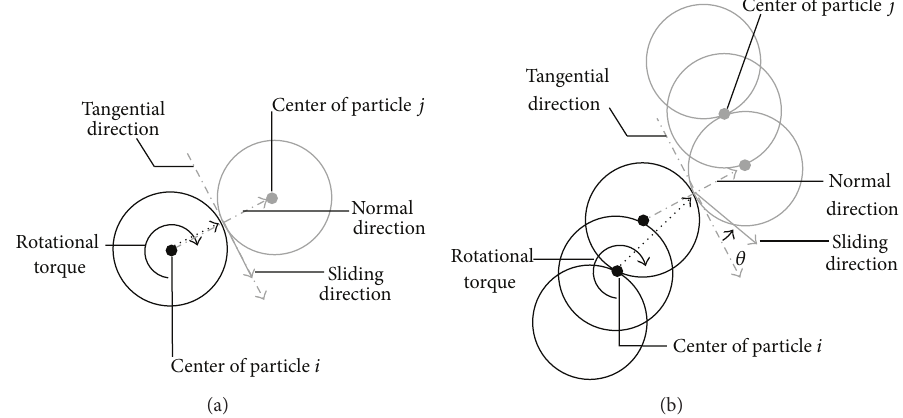
Figure 3: Contacting condition of nonspherical grains and contact angle 𝜃 . (a) Contacting condition of spherical grain and (b) contacting condition of nonspherical grain.